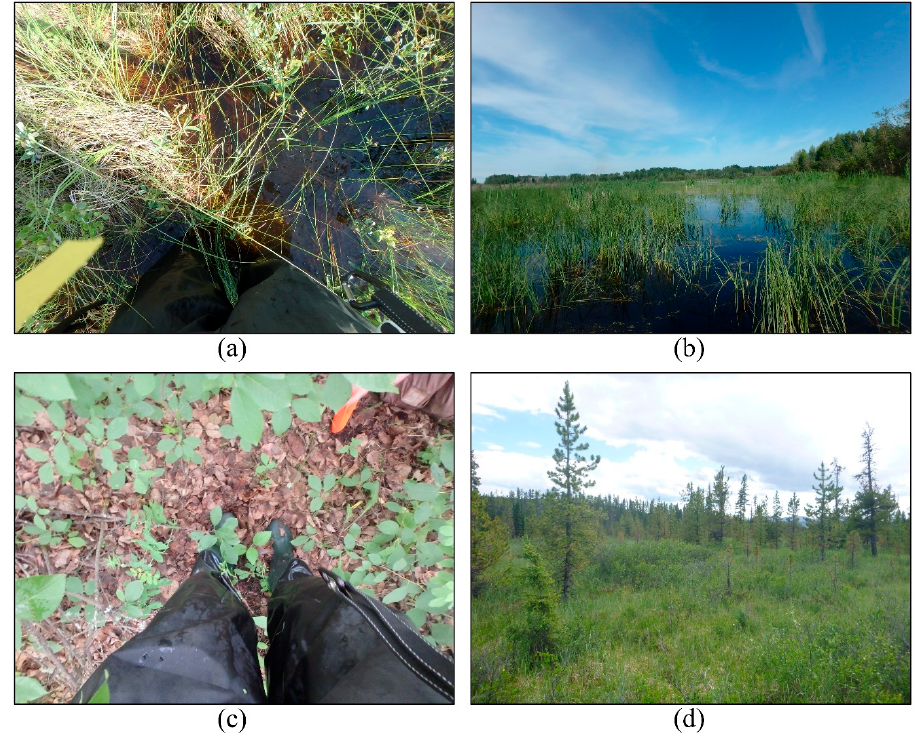
Figure 2. Examples of ( a , b ) flooded and ( c , d ) non-flooded wetlands recorded in the field.